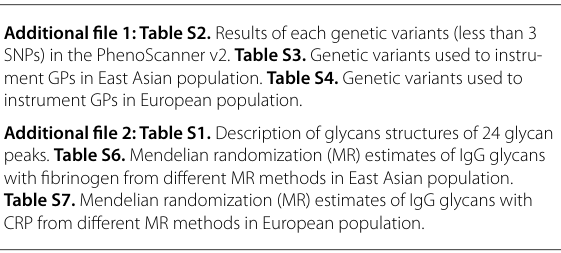
Additional file 2: Table S1. Description of glycans structures of 24 glycan peaks. Table S6. Mendelian randomization (MR) estimates of IgG glycans with fibrinogen from different MR methods in East Asian population. Table S7. Mendelian randomization (MR) estimates of IgG glycans with CRP from different MR methods in European